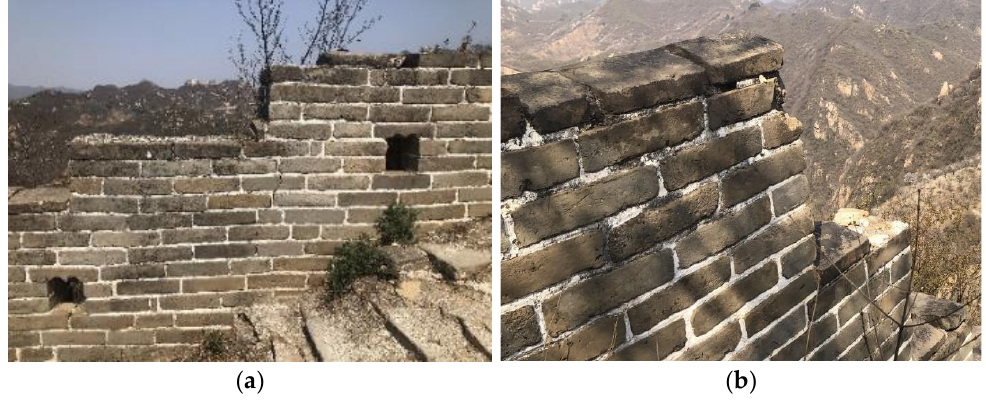
Figure 5. Parapet of the Great Wall: ( a ) Side view; ( b ) Detail.